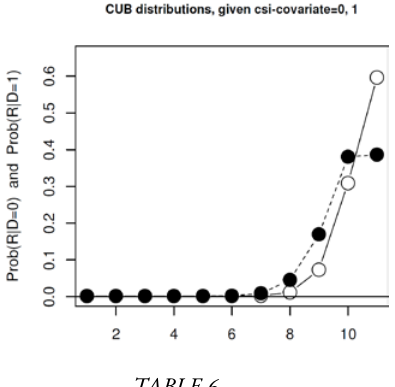
Probability distributions for children with age less or equal to 9 (circles) and for children with age greater than 9 (dots) in school A